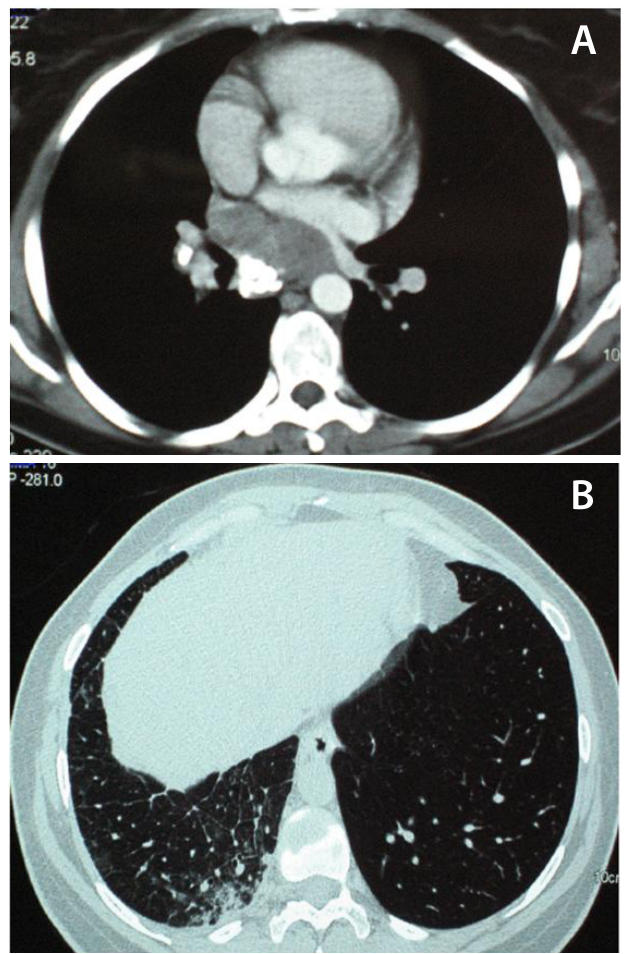
Fig. 2 – A: Axial contrast-enhanced lung CT (mediastinal windows): There is a soft tissue attenuation mass at the level of the right lower pulmonary veins. The lesion abuts the posterolateral part of the right atrium. The mass exhibits coarse calcifications in its posterior part. Note the presence of a calcified bronchopulmonary node on the right, which could be attributed to a previous granulomatous infection. B: High resolution CT scan (lung windows) at the level of the lung bases, depicting thickened interlobular septa, patchy ground glass opacities and infiltrates, consistent with regional lung congestion due to impaired pulmonary venous